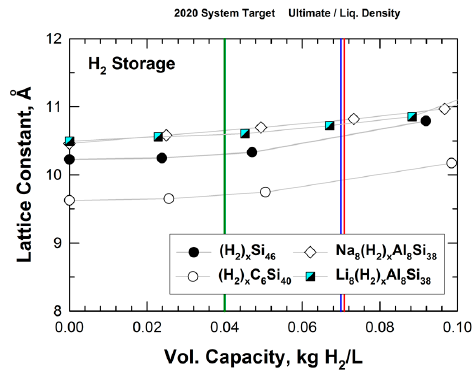
Figure 9. Predicted volumetric capacity and lattice constant for intermetallic clathrates of Si 46 , C 6 Si 40 , Na 8 Al 8 Si 38 , and Li 8 Al 8 Si 38 . The vertical green line indicates DOE’s 2020 system target, while the vertical blue line indicates the DOE ultimate fleet target for onboard storage for vehicles. The red line indicates the density of liquid hydrogen. From Chan et al. [22].